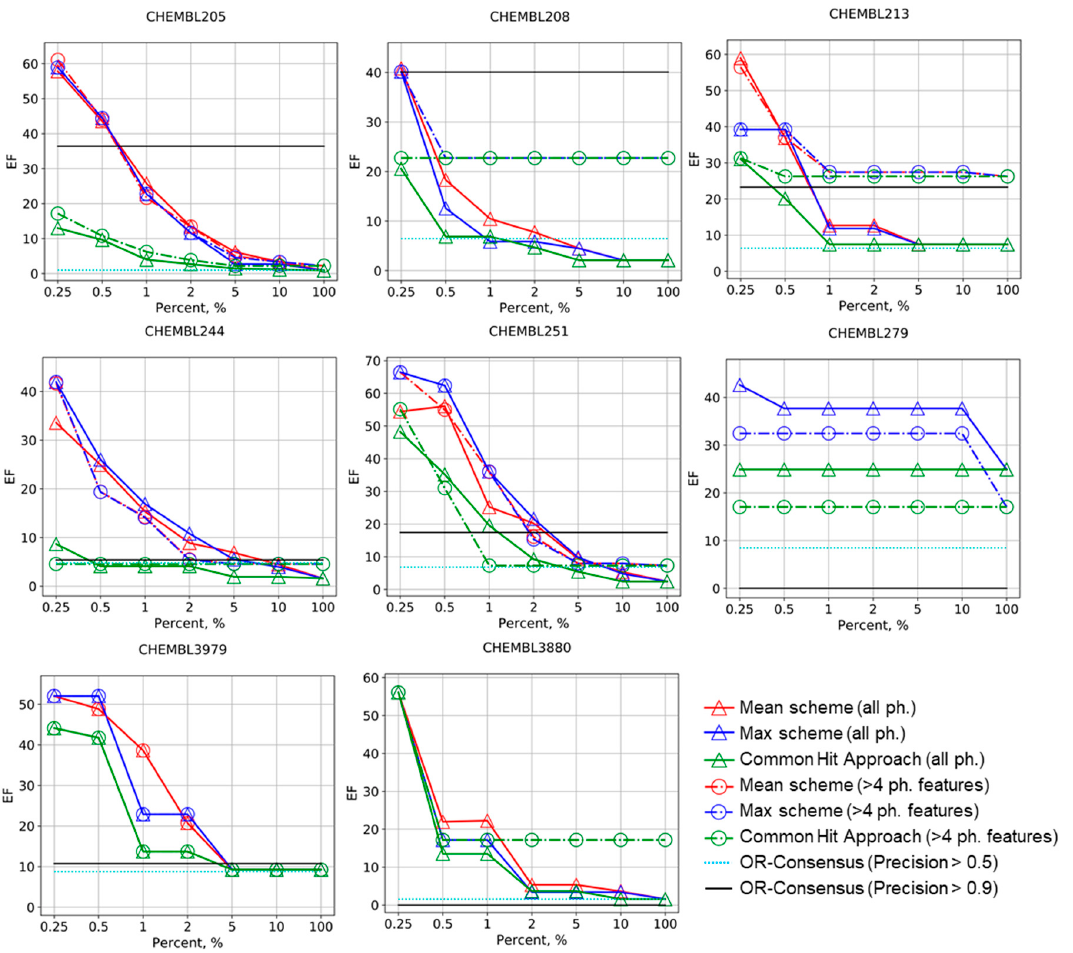
Figure 1. Enrichment factor (EF) curves for the Max, Mean, and common hits approach (CHA) schemes of molecules ranking in virtual screening for selected targets. Levels for OR-consensus models were given as horizontal lines (pharmacophores with precision greater than 0.5 and 0.9 are left). The numbers of corresponding ChEMBL targets are provided.